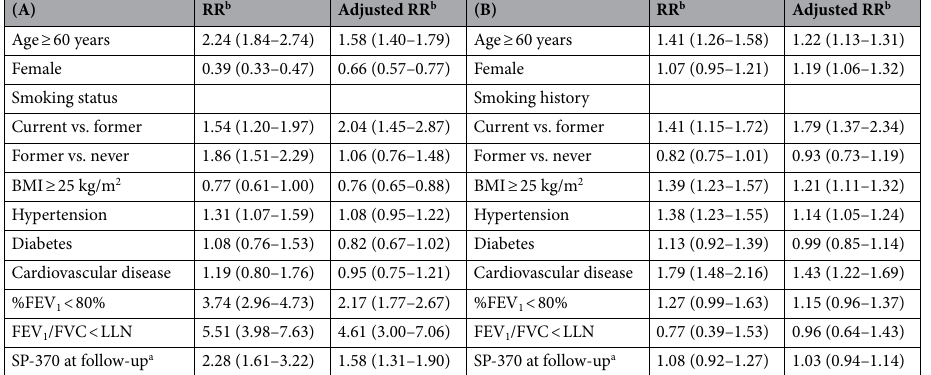
Table 3. Risks associated with the development of AFL (A) and dyspnoea (B) at 5 years. RR risk ratio, AFL airflow limitation, BMI body mass index, FEV1 forced expiratory volume in 1 s, FVC forced vital capacity, LLN lower limits of normal. a Spirometer used at follow-up. b RR (95% confidence interval).